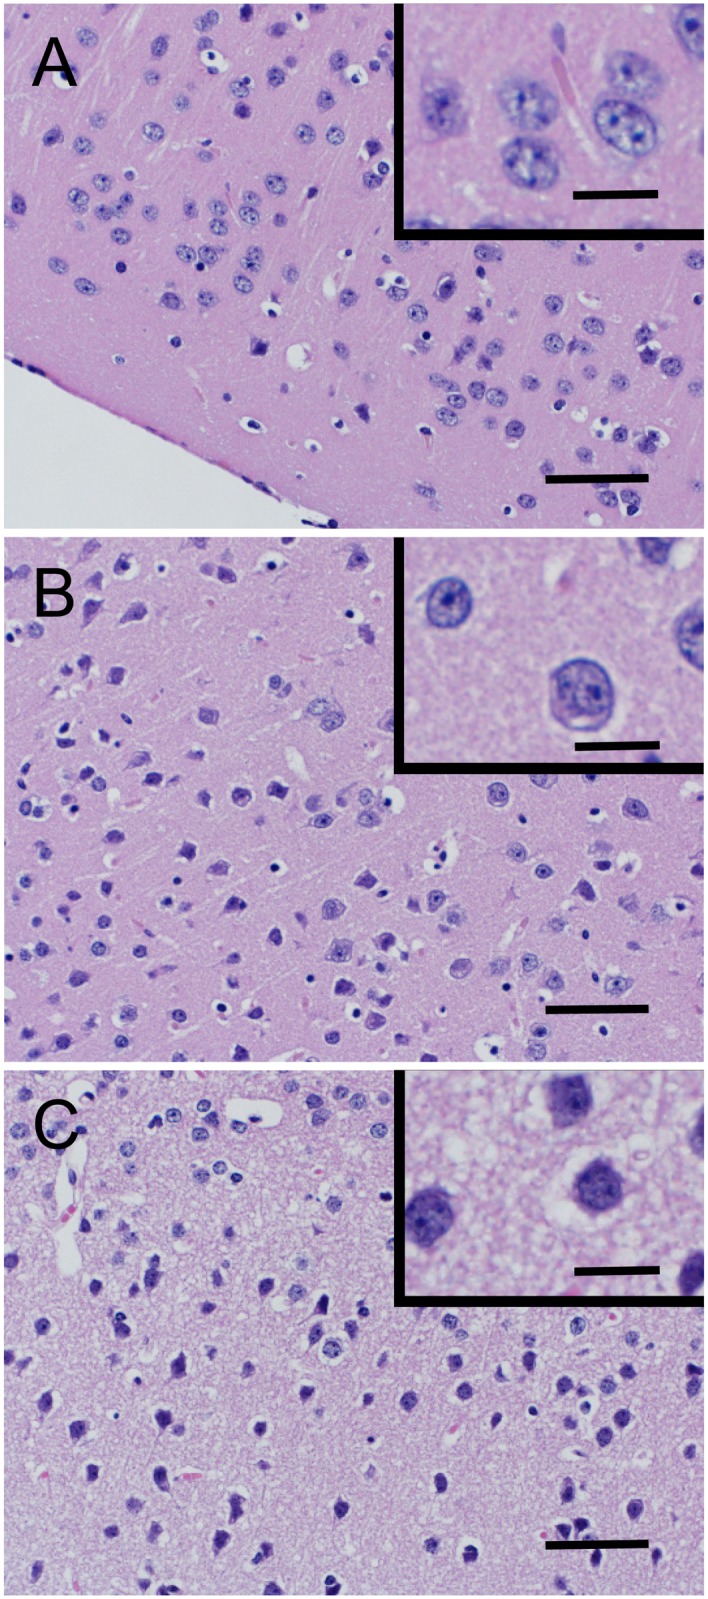
Representative histological sections of mouse cerebral cortex on the 1st postoperative days after transfusion with HbV/rHSA (A), mRBC/rHSA (B), or rHSA (C).Bars = 50 μm. Inset bars = 10 μm. Hematoxylin/eosin stain.